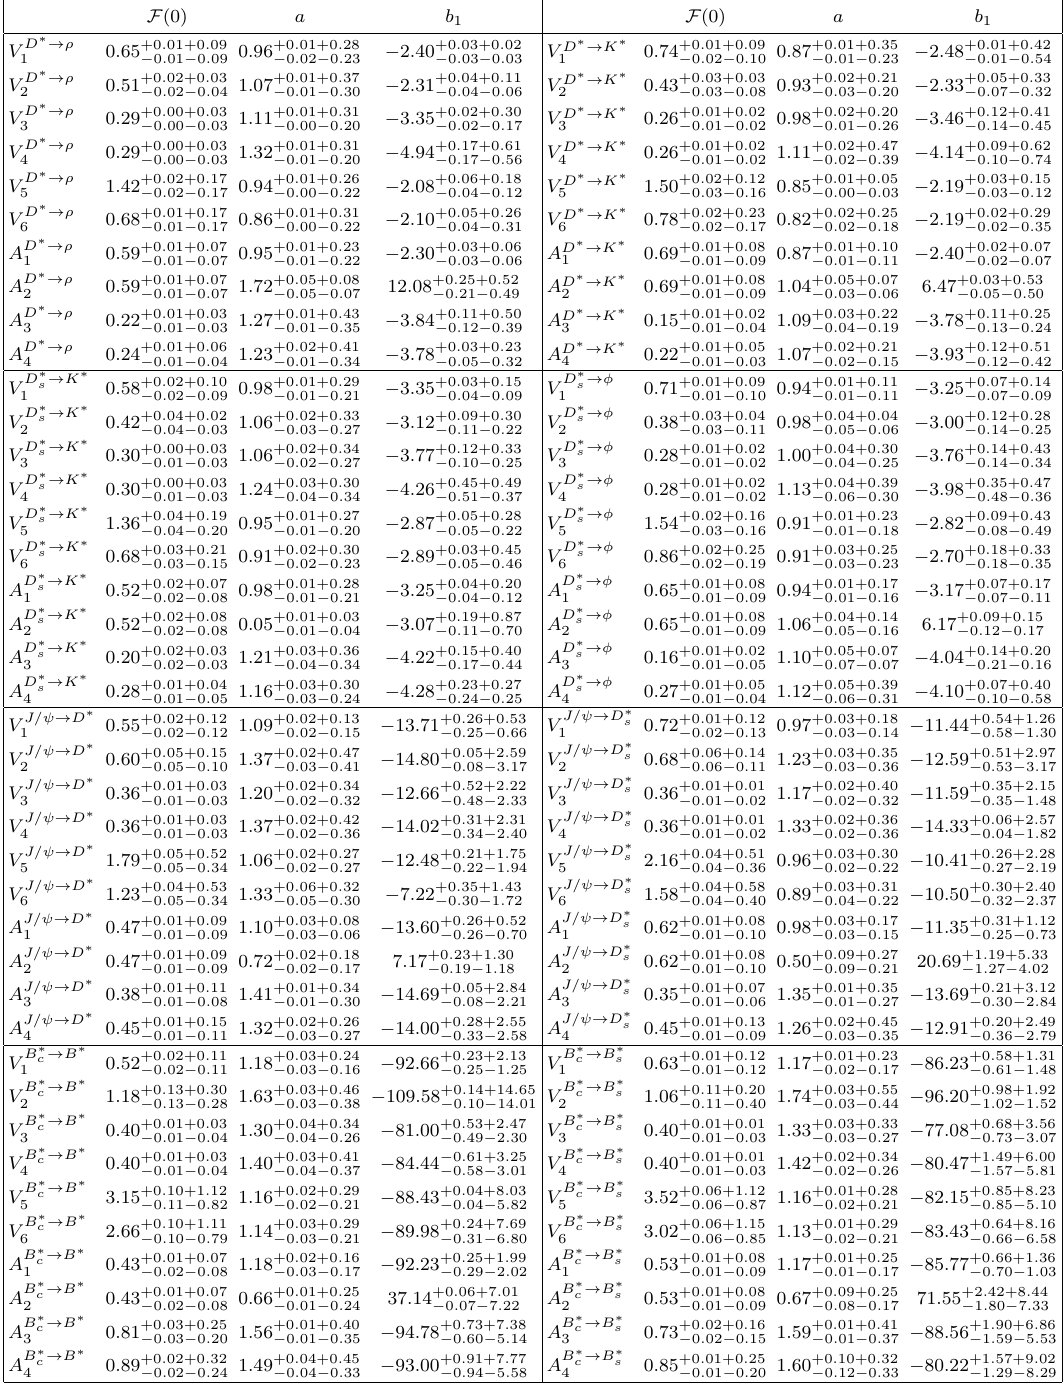
! ( K (cid:3) ; (cid:30) ), s